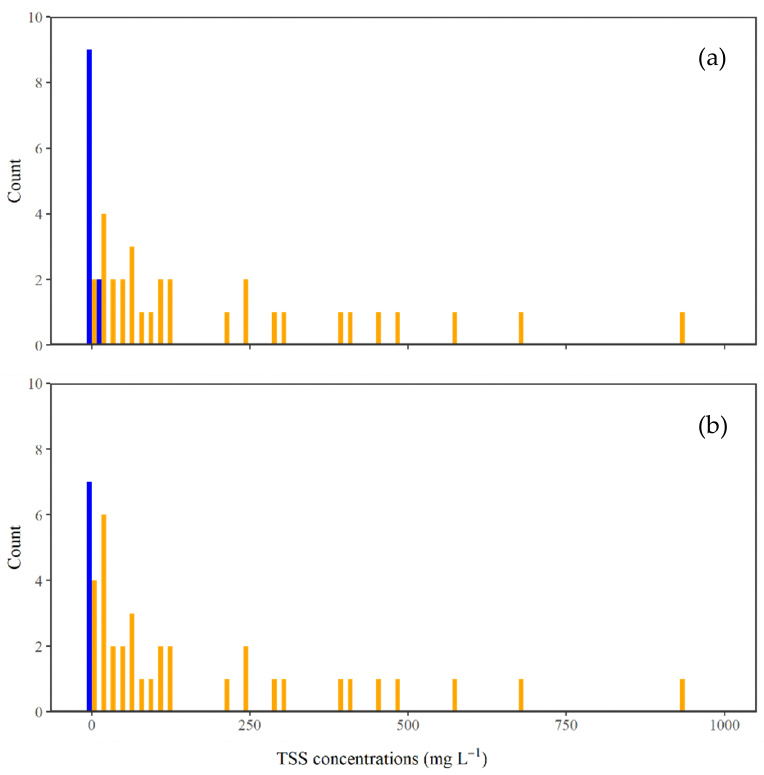
Figure 2. Distribution of TSS concentrations in river water samples under base- (blue) and high-flow (orange) conditions. ( a ) Raw data; ( b ) Redefined data based on the median of raw data collected under base-flow conditions.